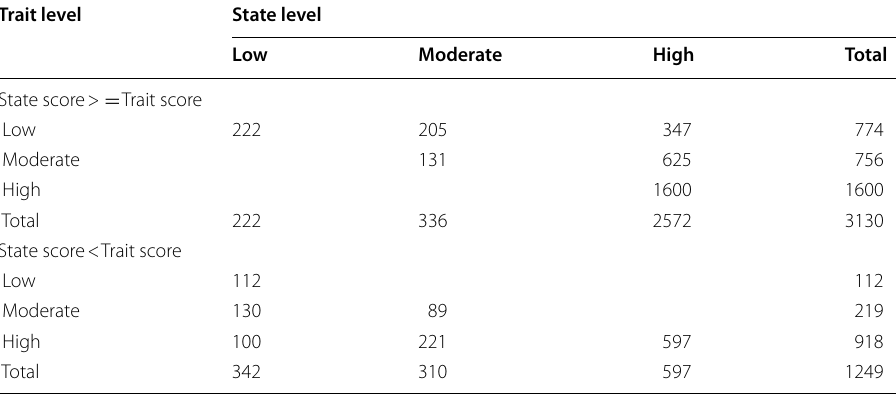
Table 4 Transition matrix by level of trait and state anxiety Trait